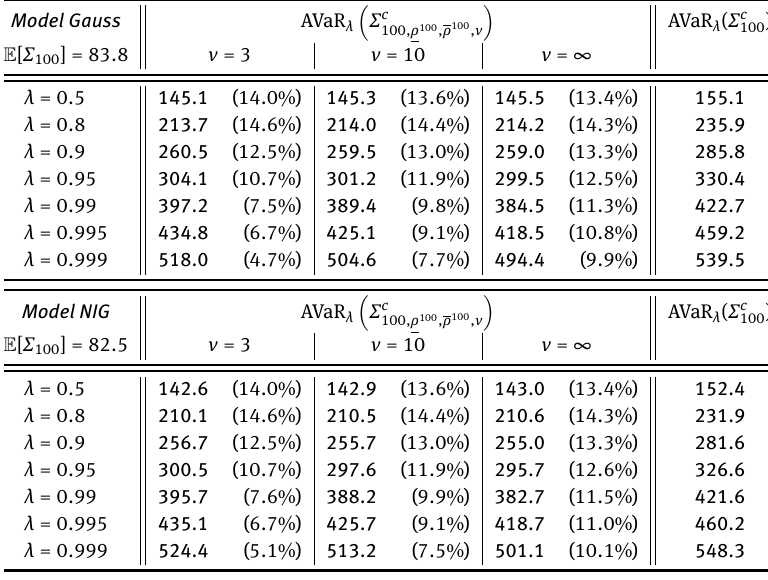
Table 5: Comparison of the improved risk bound AVaR λ ( Σ c for AVaR λ ( Σ 100 ) in Model Gauss resp. NIG for T = 100 trading days for different levels λ , for different ν and for fixed ρ 100 = 0.6703 and ρ 100 = −0.2905 . The relative DU-improvement given by 1 − (AVaR E [ Σ 100 ]) is displayed in